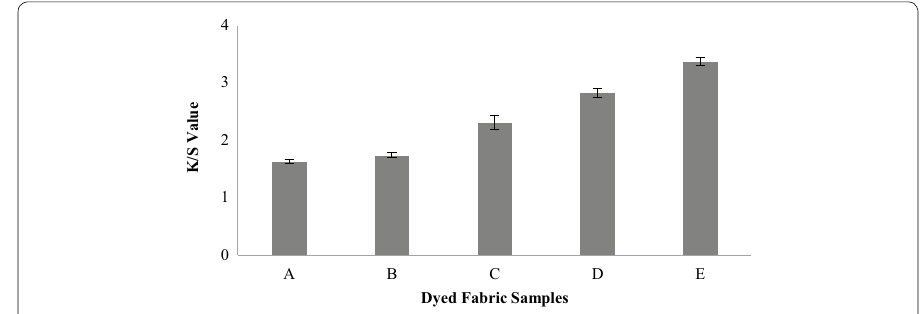
420 nm) of henna dyed polyester fiber =